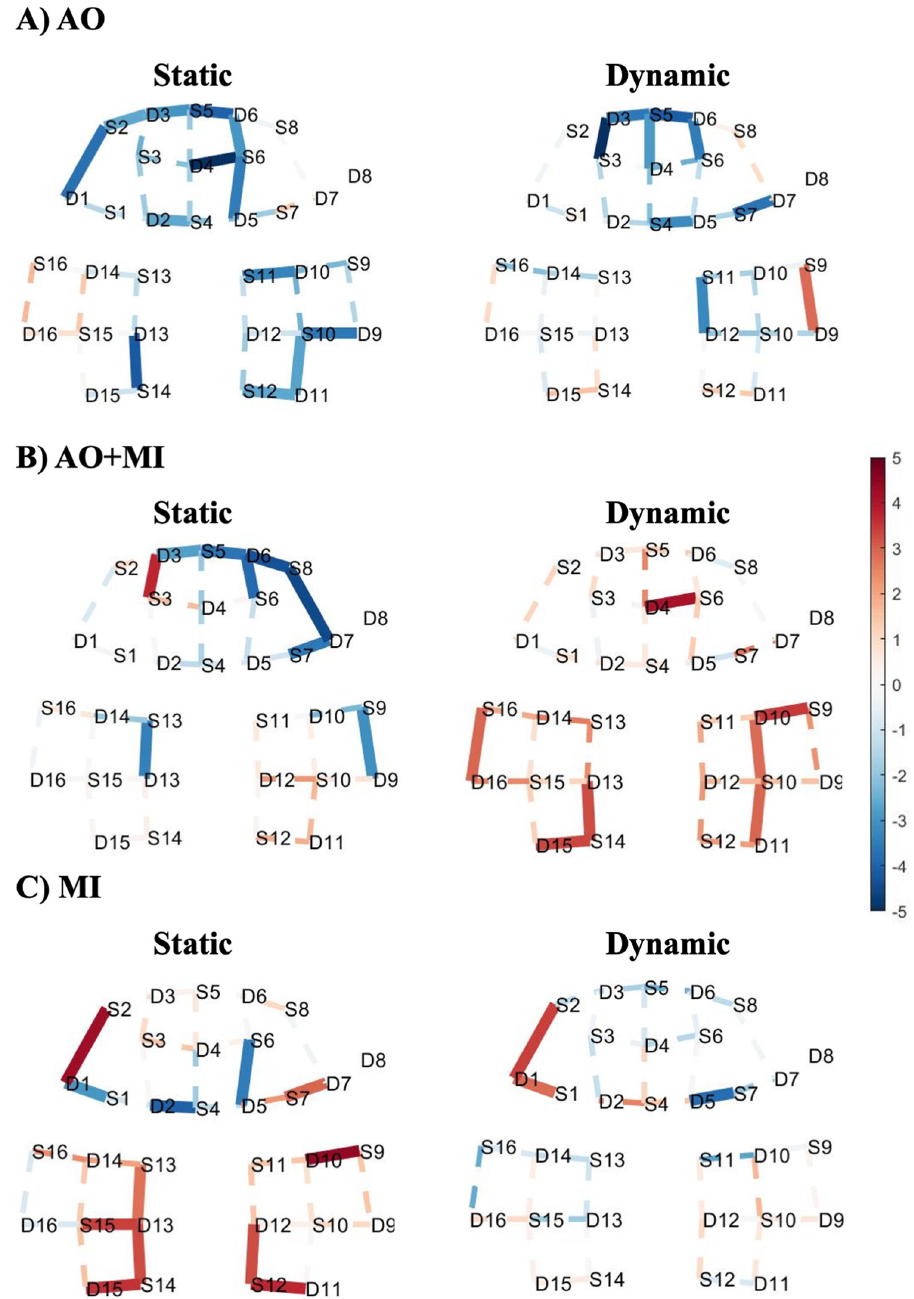
Fig 3. T-map of oxy-hemodynamic response (HbO) corresponding to (A) action observation experiment, (B) a combination of motor imagery and action observation experiment, and (C) motor imagery experiment during static standing balance task (left) and dynamic standing balance task (right). These maps are generated by contrasting each task against the baseline. Significantly activated channels at p < 0.05 (FDR corrected) are indicated by thick and solid lines. The red colour indicates stronger task activity against the baseline. The dashed line shows the channels that were not statistically significant. This map was generated by using NIRS Brain AnalyzIR Toolbox [51]. Fig 2 illustrates the referencing for the brain regions with 10–20 EEG system